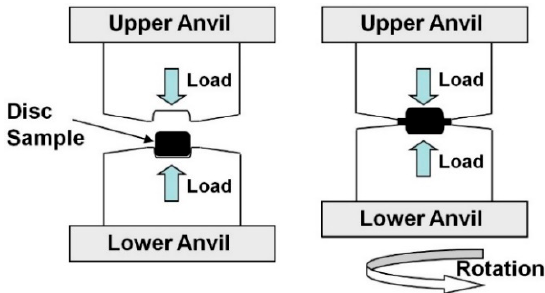
Figure 1. Principles of high-pressure torsion method, which includes a disc-shaped sample and two pressure-resistant anvils, made from tool steels or WC—11 wt% Co composites, with shallow and circular flat-bottomed holes on their surfaces.